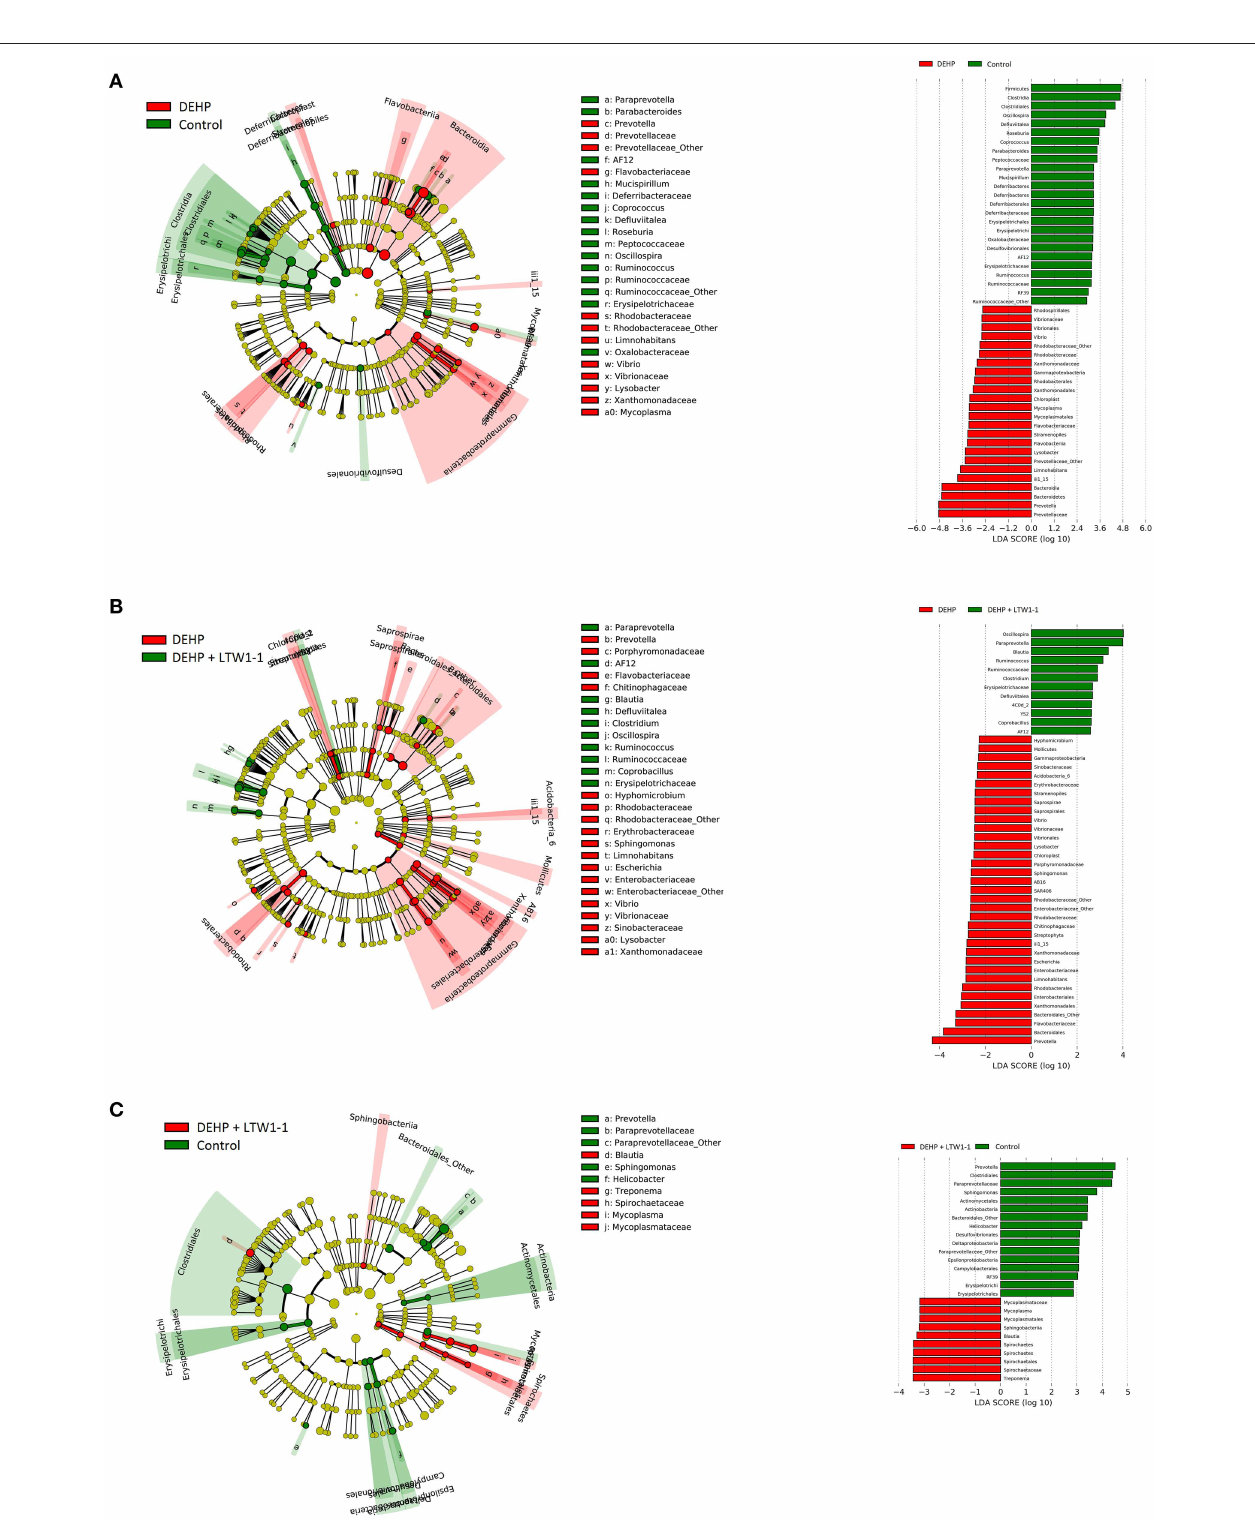
FIGURE 6 | Cladogram and corresponding LDA scores showed the most differentially abundant taxa in gut microbiota from phylum to genus. (A) The taxa most highly associated with DEHP (red) or Control (green) and (B) DEHP (red) or DEHP + LTW1-1(green) and (C) DEHP + LTW1-1(red) or Control (green). Circle sizes in the cladogram plot are proportional to bacterial abundance. The circles represent, going from the inner circle to the outer circle: phyla, genus, class, order, and family.